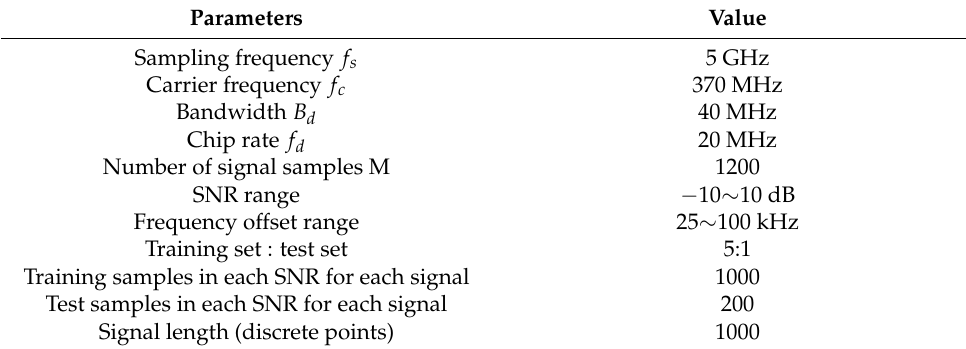
Table 1. Parameters of the simulation data.